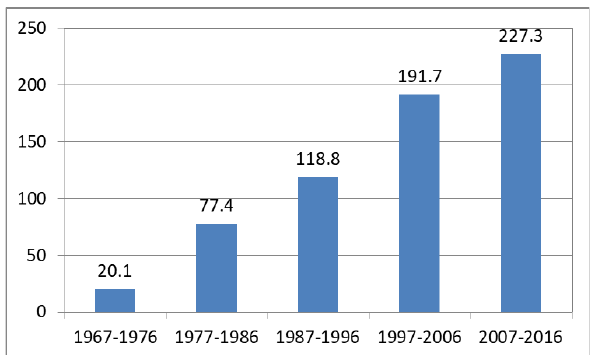
Figure 1. Average Number of extreme events per year by Decade,